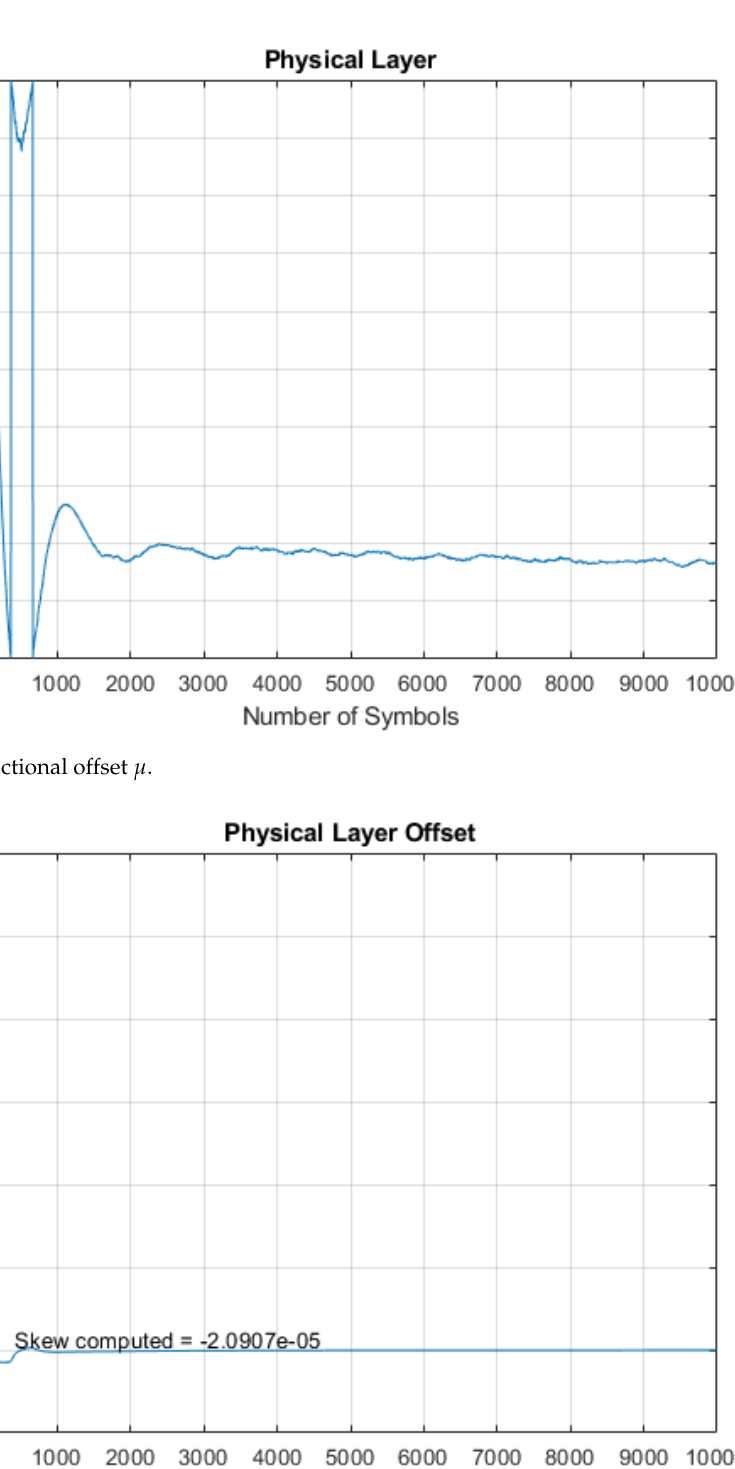
Figure 14. Computation of skew offset using the LS